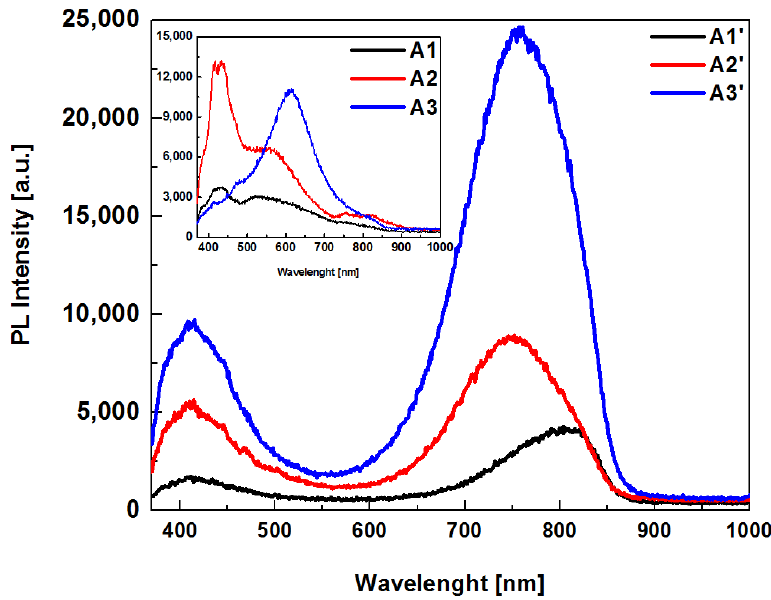
Figure 6. PL spectra measured from deposited SRO films. Inset shows PL spectra of unannealed SRO films.